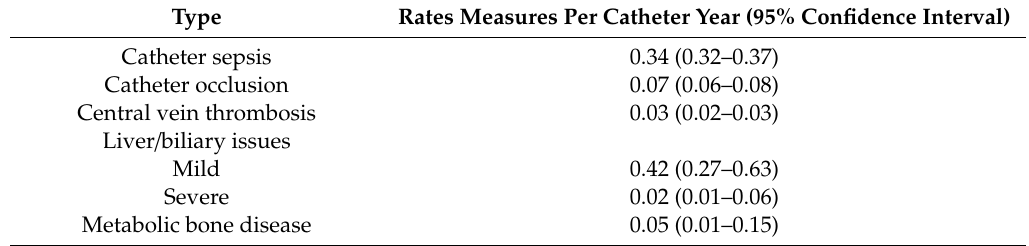
Table 2. Catheter- and parenteral nutrition (PN)-related complications